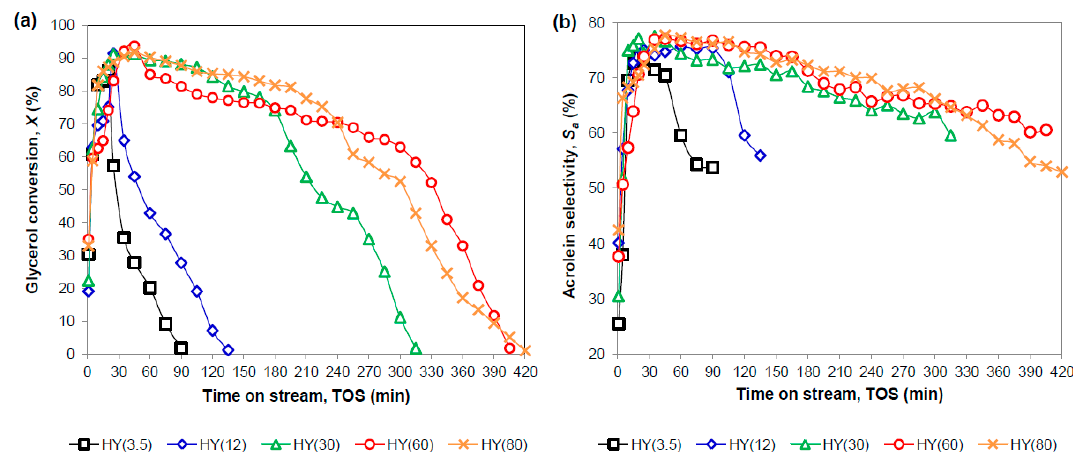
Figure 8. ( a ) Glycerol conversion and ( b ) acrolein selectivity of HY zeolites with time on stream.